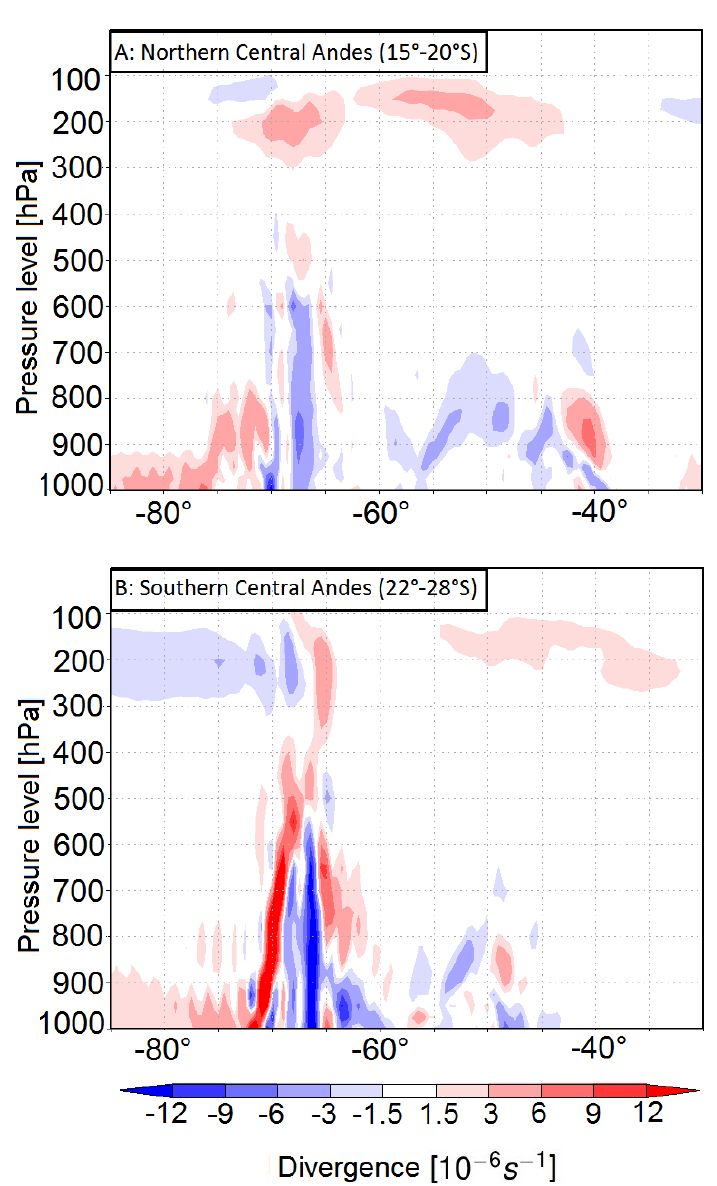
Figure 2. Average divergences for DJF (1999–2013) for the latitude band 15 ◦ –20 ◦ S ( A ) and for the latitude band 22 ◦ –28 ◦ S ( B ) based on ERA-interim reanalysis data. See Equation (2) for the divergent calculation. Negative divergence is located east of the Andes at 67 ◦ W and indicates the low-level convergence activity along the mountain front of the south–central Andes. The upper level divergence at 200 hPa is the Bolivian High (Figure 3, white box) and is a result of strong convection during austral summer. Note the stronger negative and positive divergence values in the sub-tropical south–central Andes ( B